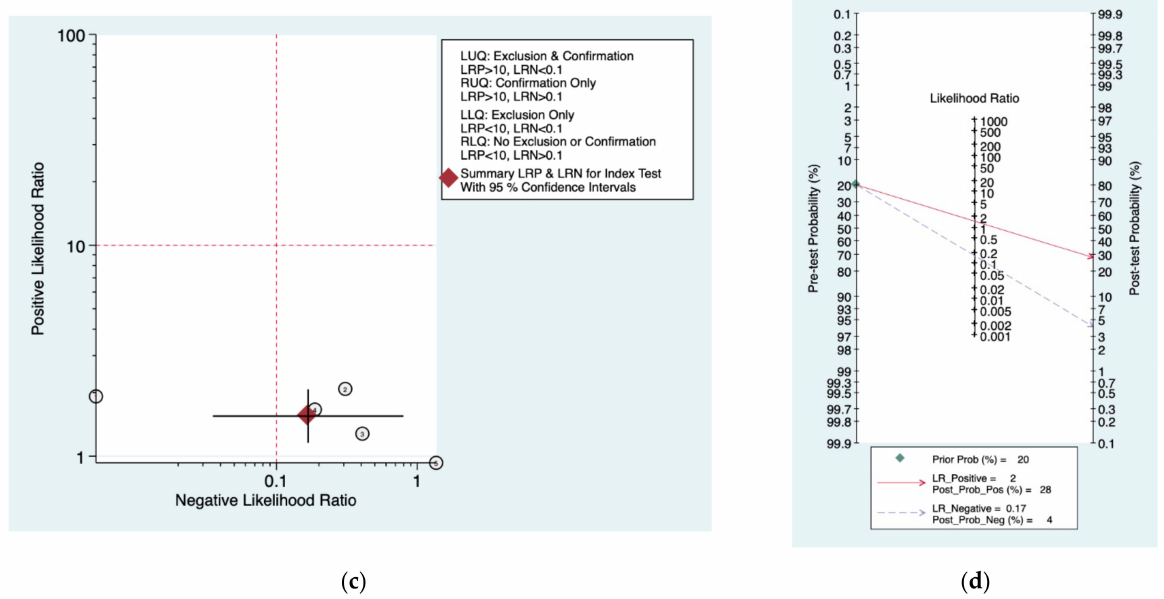
Figure 2. Meta‑analysis of Mangham protocol. ( a ) Forrest plot of pooled sensitivity and